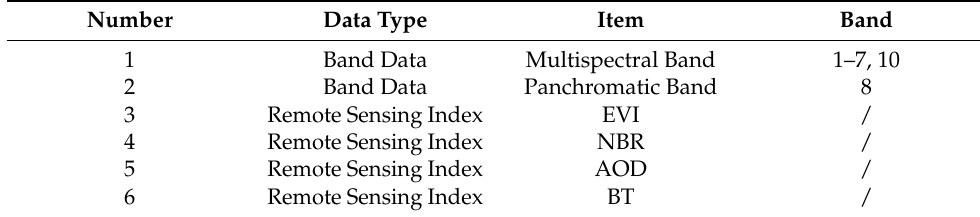
Table 3. Bands and remote